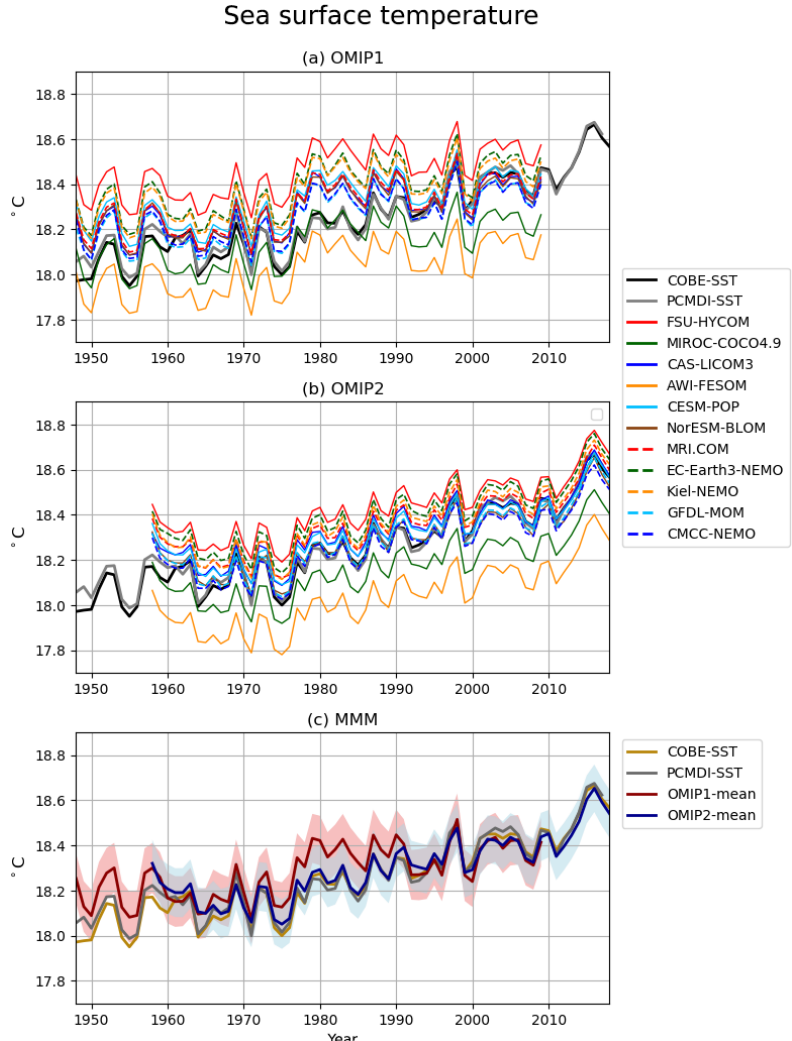
Figure 21. Same as Fig. 19 but for the globally averaged sea surface temperature ( ◦ C). Observational estimates by COBE-SST (Ishii et al., 2005) and PCMDI-SST are depicted as references. The model spreads ( ± 2 σ ) of both OMIP-1 and OMIP-2 capture the observation for the entire period. The z score of the difference between OMIP-1 and OMIP-2 for the period from 1980 to 2009 is − 0 . 46 (see also Table